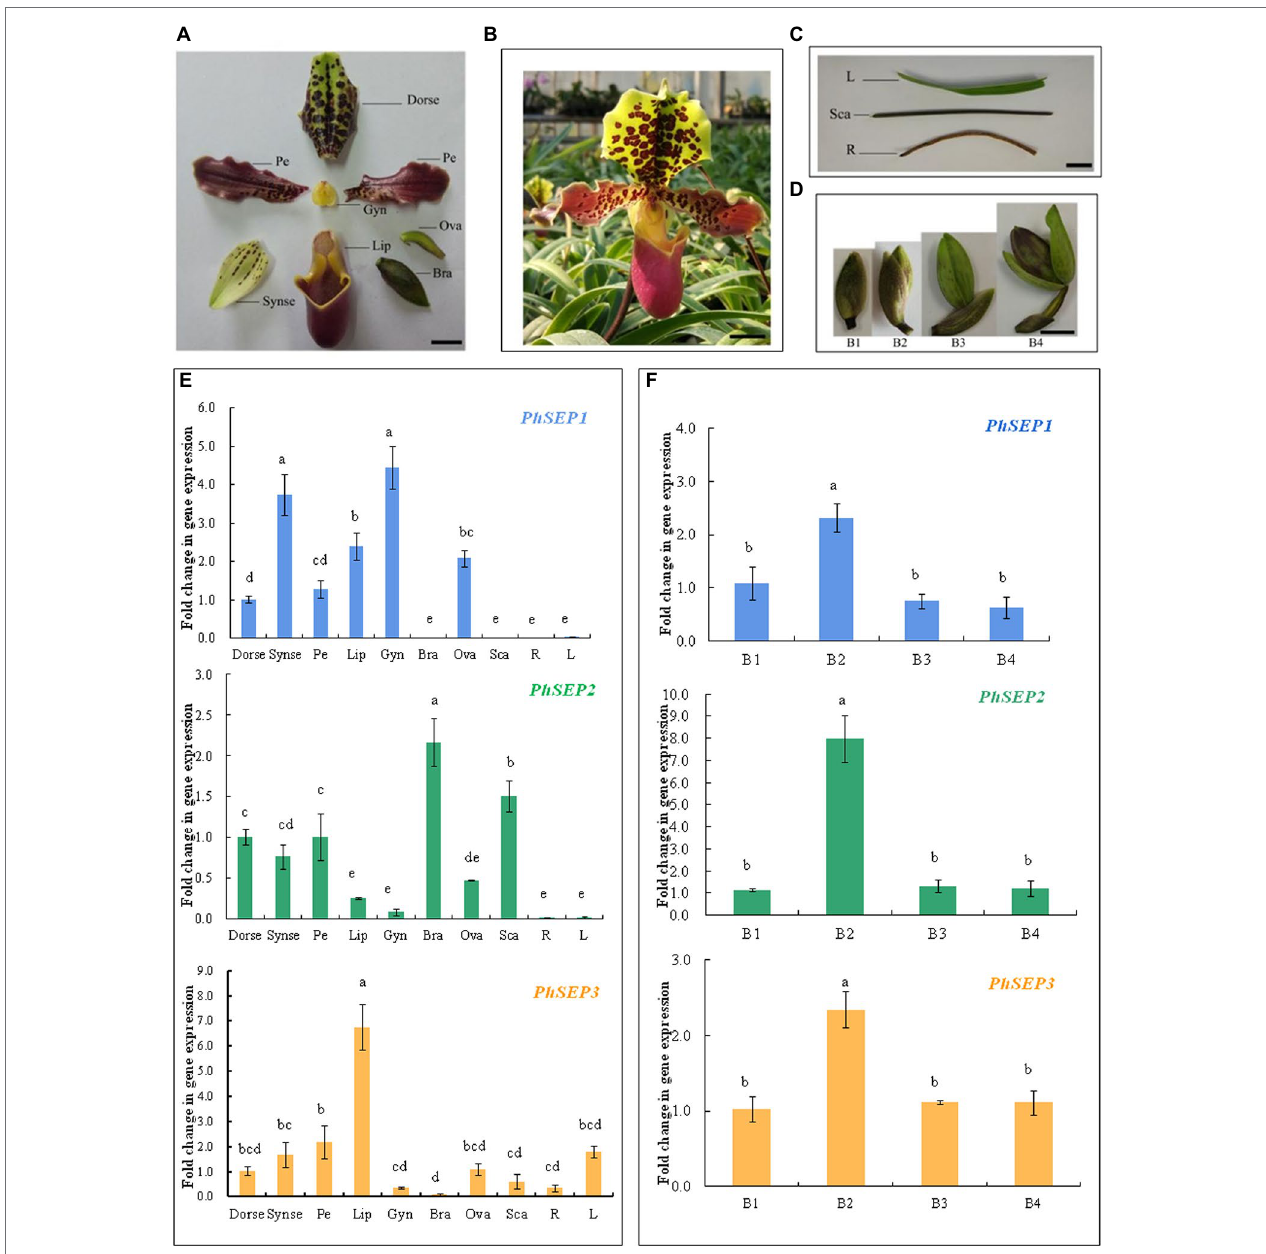
FIGURE 4 | Transcript levels of PhSEP genes in different tissues and organs and at different developmental stages of floral buds of P. henryanum . (A) A flower dissected as follows: Dorse, dorsal; sepal; Synse, synsepal; Pe, petal; Lip; Gyn, gynostemium; Bra, bract; Ova, ovary. (B) Mature flowers. (C) Vegetative tissues dissected as follows: R, root; Sca, scape; L, leaf. (D) Floral buds at different developmental stages. (E) Relative expression patterns of PhSEP1, PhSEP2, and PhSEP3 in different tissues and organs. (F) Relative expression patterns of PhSEP1, PhSEP2, and PhSEP3 at four stages of floral development. Scale bars: 10 mm; The values are means of three replicates ± SE. Statistical analysis was performed using one-way ANOVA test ( p < 0.05). Different letters represent significant difference. The expression level of gene in Dorse or at stage B1 was set to 1, and those of others were normalized to